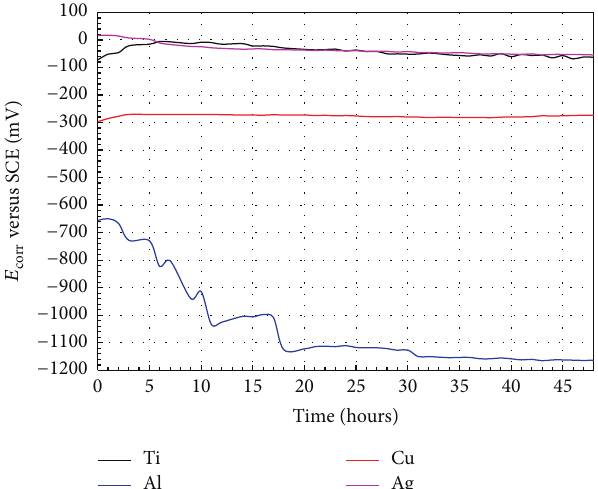
Figure 5: 𝐸 corr values after testing time for the pure elements in artificial saliva at 37 ∘